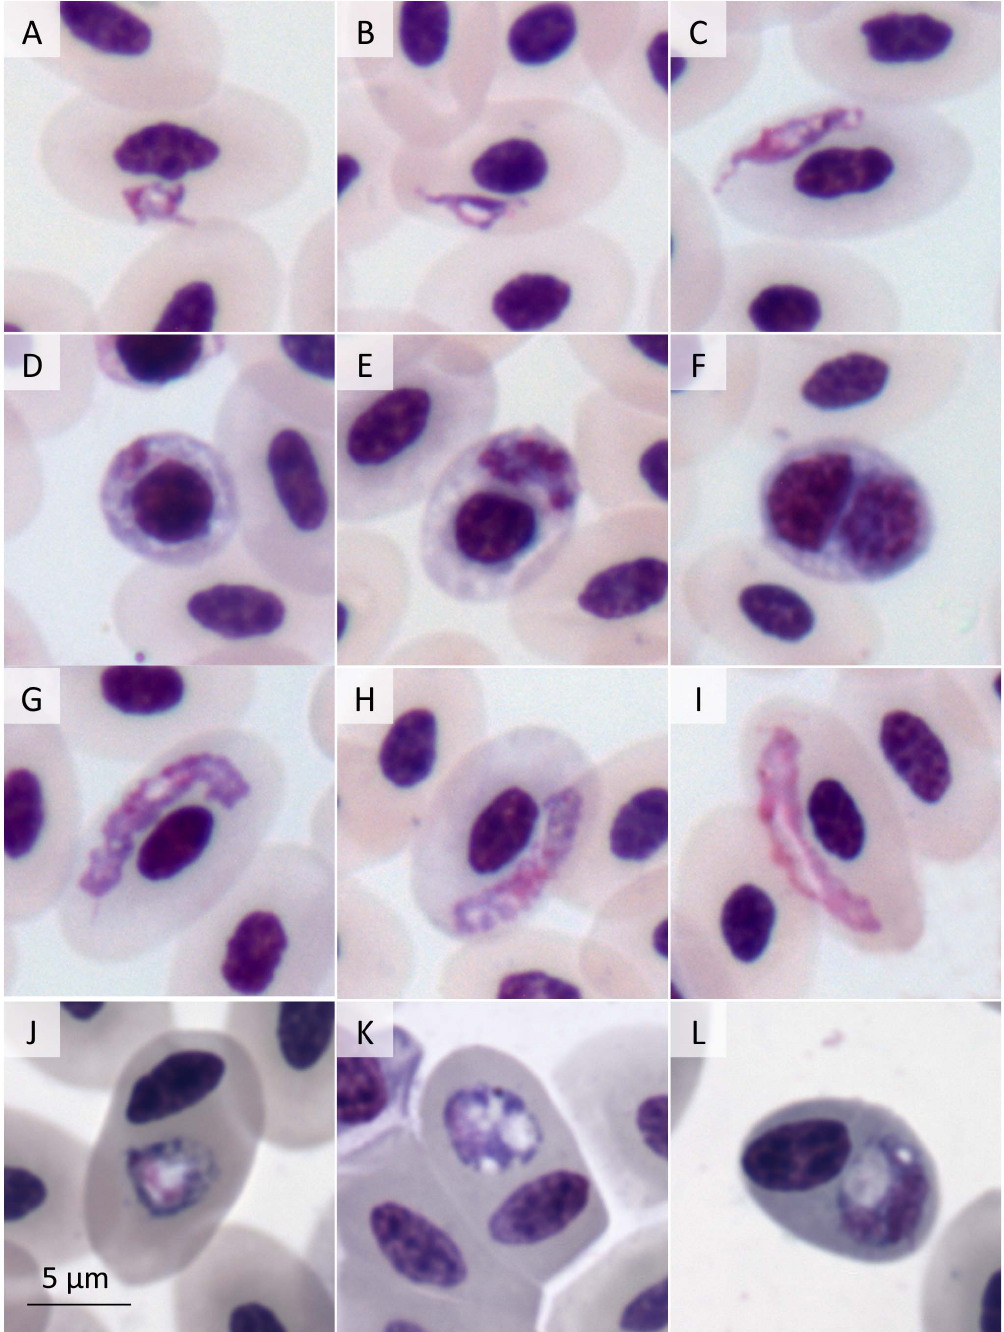
Figure 2. Blood parasites in Giemsa-stained blood smears from Magellanic penguins ( Spheniscusmagellanicus ). Plasmodium ( Huffia ) elongatum (508B) trophozoites (a–d), meronts (e,f), macrogametocytes (g,h) and microgametocyte (i); chloroquine-degenerated Plasmodium ( Haemamoeba ) sp. (503B) (j–l).